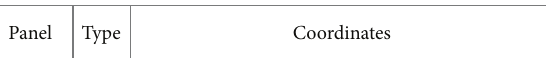
Figure 7: Message fields format for Smart Panel version 3P.